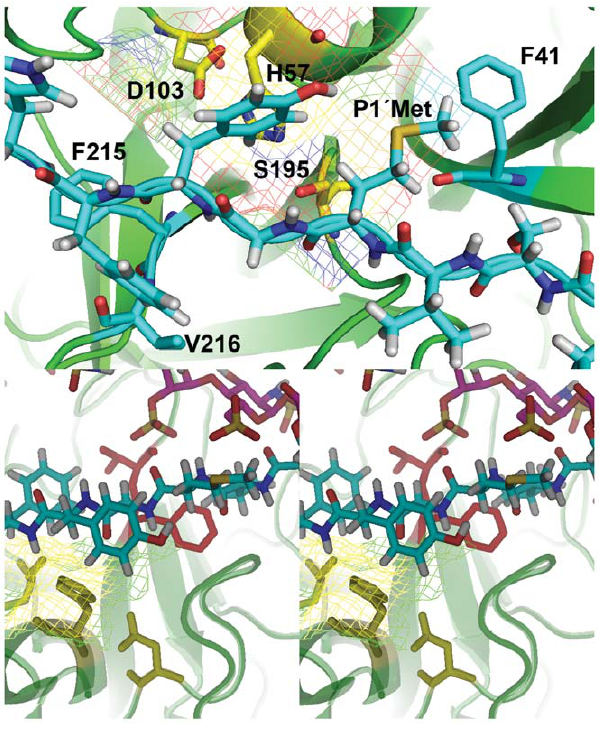
Figure 6. Representation of the complex of both FRET-peptide and heparin with HNE. A , Docking of HNE with the substrate AMESVMGYFHRSQ,the secondary structure elements of the HNE are represented by indigo blue schematics ( arrows for extended strands, and cylinders for helices).The carbon atoms of the substrate are indicated by a green sticks , view of the minimum energy conformation from docking, showing the substrate labeled at P1Val and P1’Met completely engulfed inside the HNE active site cavity: S195, H57 and D103 (dark blue for nitrogen atoms, light yellow for carbon atoms, red for oxygen atoms, grey for hydrogen atoms and dark yellow for sulfur). HNE active site residues are labeled following the numbering of chymotrypsin. B , Docking of HNE with heparin,the secondary structure elements of the HNE are represented by green schematics ( arrows for extended strands, and cylinders for helices) and the catalytic residues of the HNE are labeled.The carbon atoms of heparin chain are indicated by a cyan sticks and its sulfur atoms are indicated by dark yellow. C , Enlarged view of the HNE catalytic residues S195, H57 and D103 with substrate labeled at P1Val and P1’Met. D , Stereo view of the ternary complex between HNE N Heparin N Substrate, the secondary structure elements of the HNE are represented by green schematics . The carbon atoms of the substrate are indicated by a cyan sticks and the carbon atoms of heparin are indicated by magenta sticks